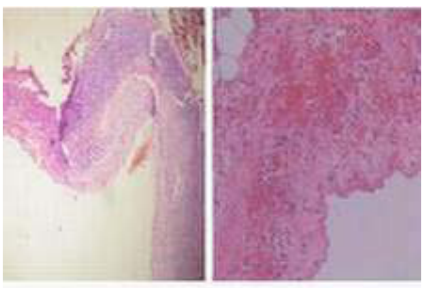
FIGURE 2 . (Left) A representative cross-section of the entire cyst within the adrenal gland. (H-E stain); (right) many strips of loose fibrovascular tissue with some fibroblastic proliferation with extensive